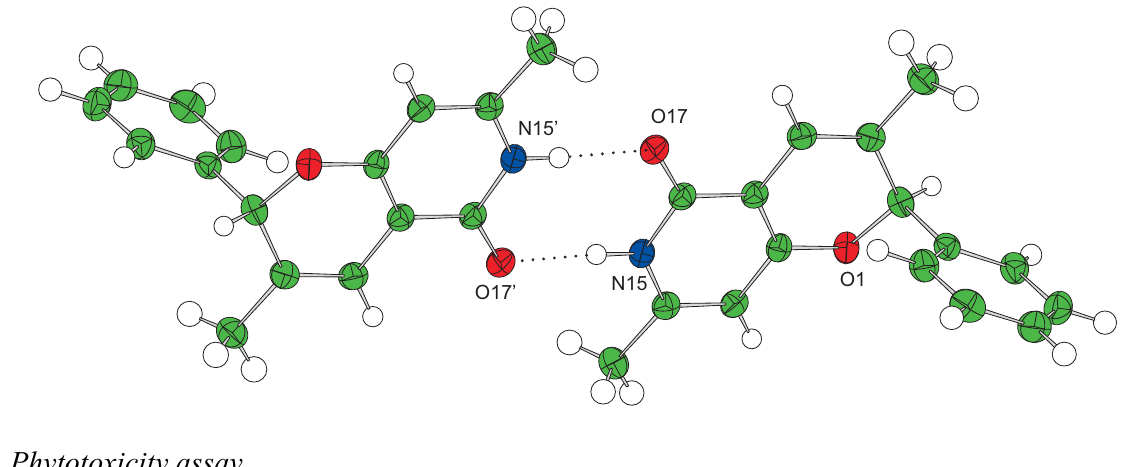
Figure 3. Single crystal structure of 4h’ showing the hydrogen bonding amide dimer. Atomic displacement parameters are shown at 50%